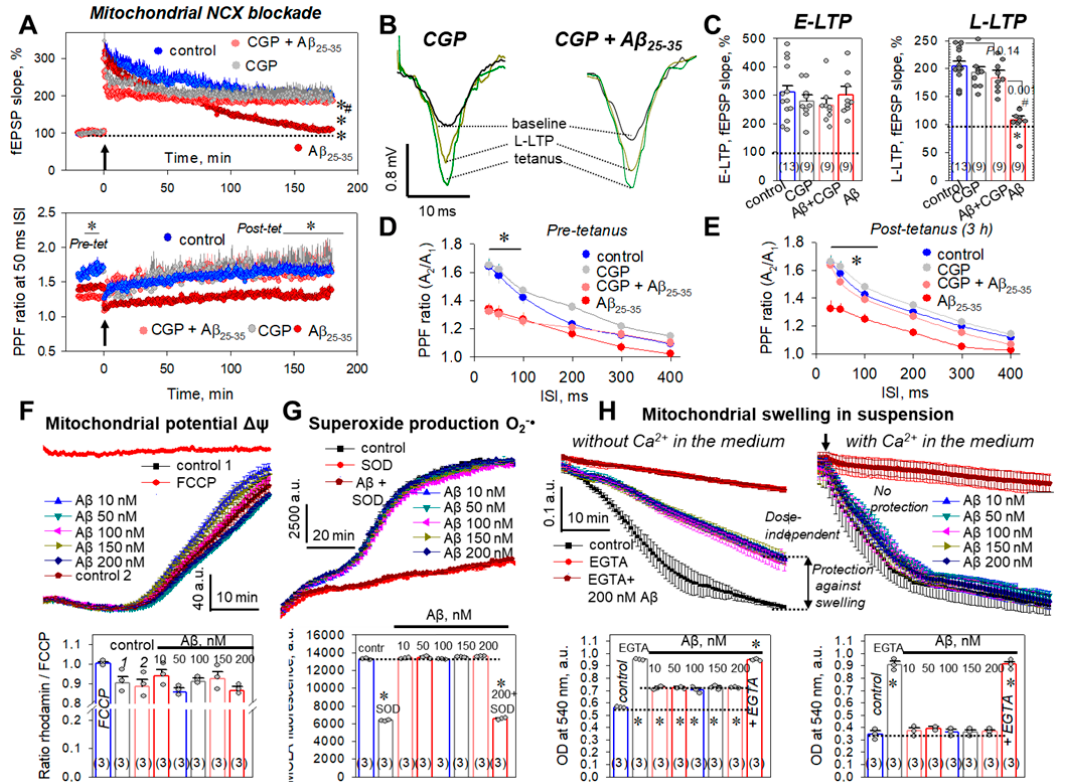
Figure 5. Specific mNCX blockade during the A β 25-35 -dependent impairment of hippocampal synaptic plasticity and A β 25-35 influence on the functional parameters of brain mitochondrial suspension. ( A ) Averaged curves for control slices (blue circles, n = 13), CGP37157-treated slices (10 μ M, CGP, gray circles, n = 9), A β 25-35 -treated slices (dark red circles, n = 9), and CGP37157 + A β 25-35 -treated slices (red circles, n = 9). Arrow at 0 min indicates start of tetanic stimulation; dotted line 100% represents normalized fEPSPs corresponding to the pre-tetanic level. Bottom panel represents paired-pulse facilitation (PPF) curves at the 50 ms ISI. ( B ) Typical fEPSP responses of studied groups for